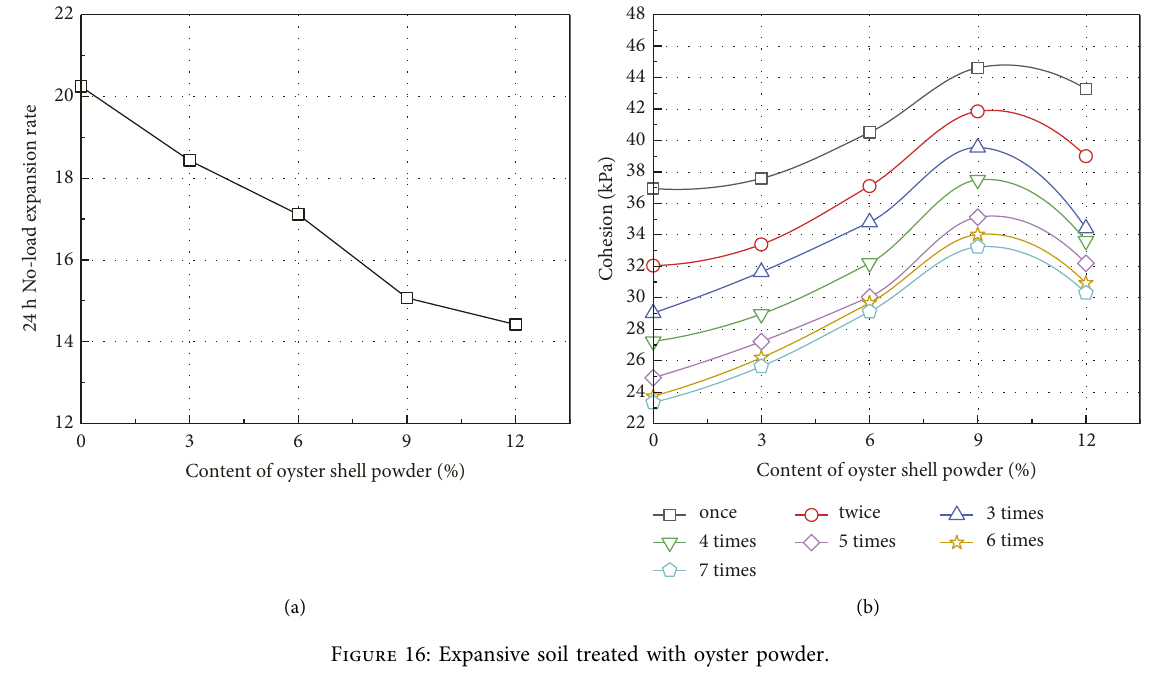
Figure 16: Expansive soil treated with oyster powder.